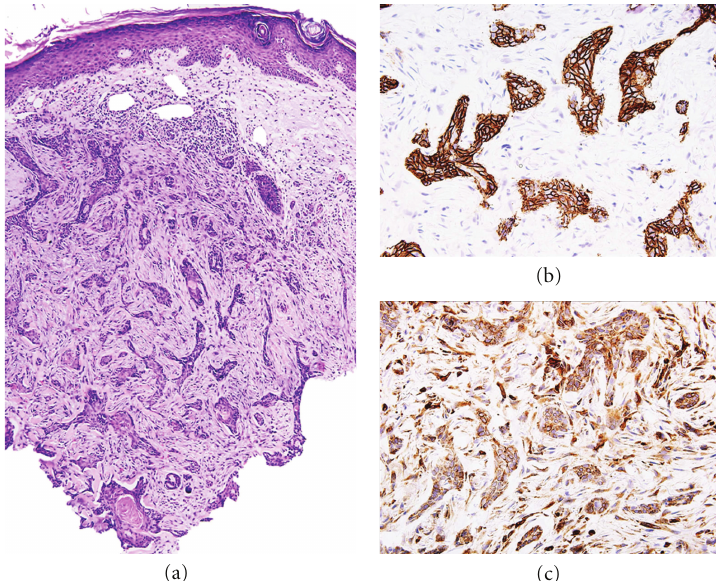
Figure 21: Basal cell carcinoma: (a) low power magnification showing infiltrative irregular islands of basaloid tumor cells which appear to have more ample eosinophilic cytoplasm mimicking the appearance of SCC (H&E, × 100). (b) Tumor cells are diffusely positive for Ber-EP4. (c) Tumor cells also show diffuse positivity for bcl-2.